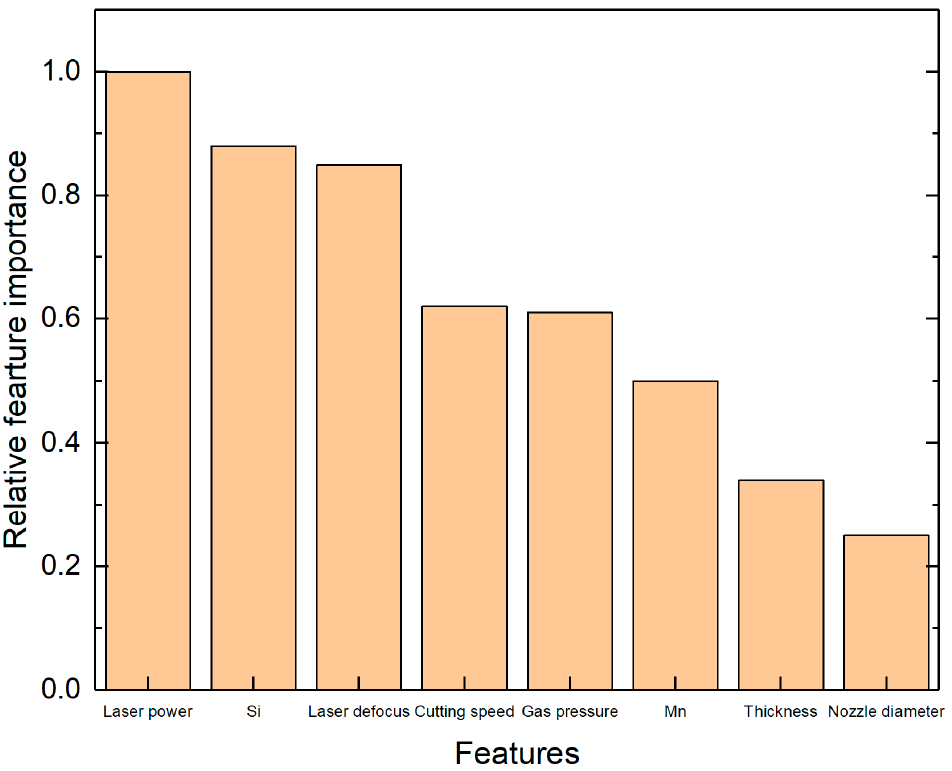
Figure 7. The feature importance ranking in the fitted model, calculated by counting the number of split nodes with the speci fi c feature as the reference.